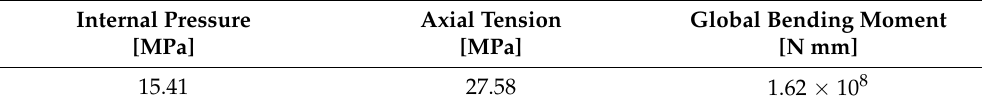
Table 8. Loading conditions.